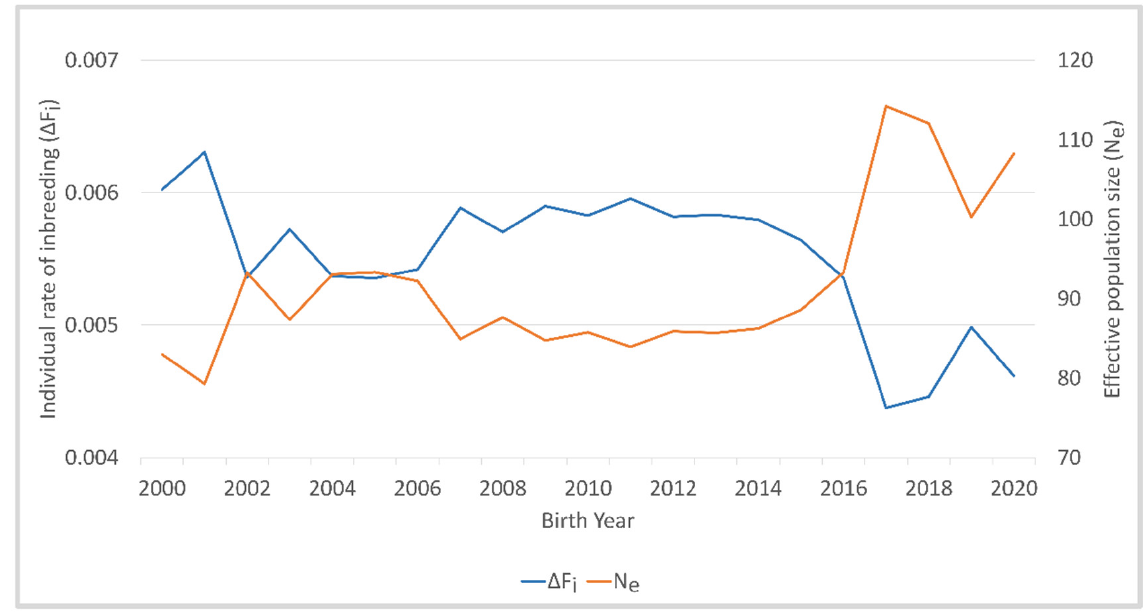
Figure 3. Individual rate of inbreeding ( ∆ F i ) and effective population size ( N e ) of Deutsch Drahthaar dogs for the birth years 2000 to 2020.